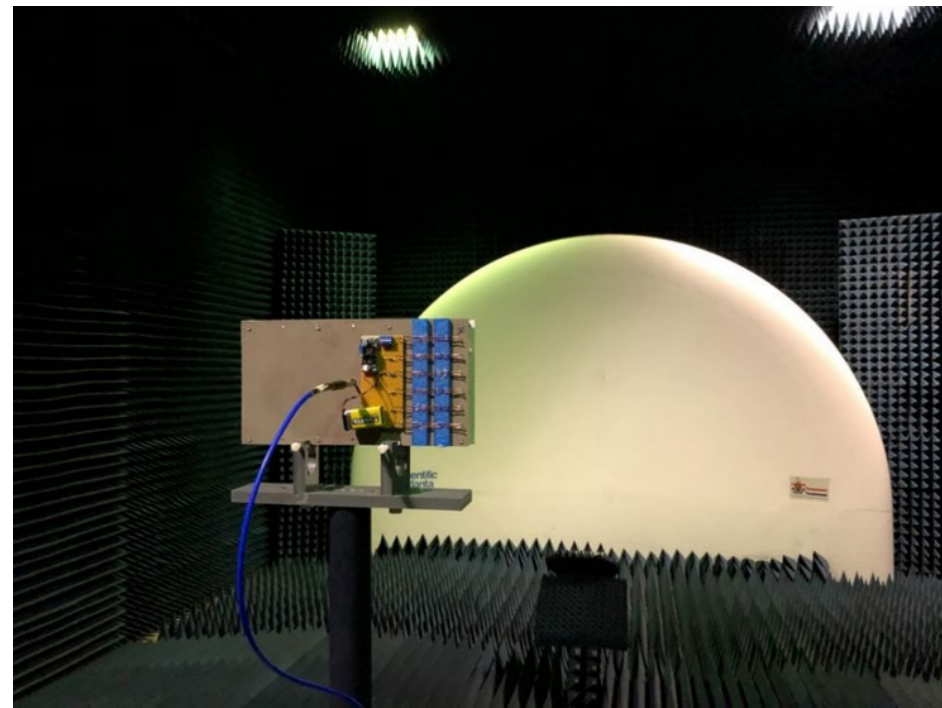
Figure 5. Antenna measurement set-up.